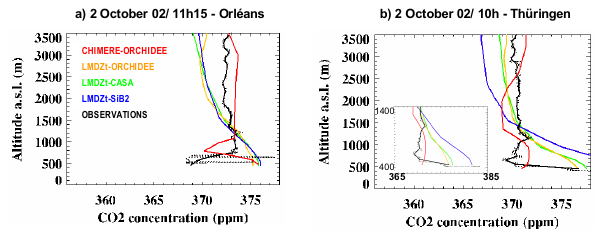
Fig. 5. Comparison between observed and modeled profiles for 2 case studies during the CAATER 2 campaign.